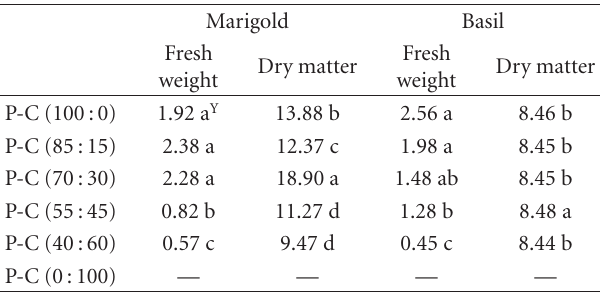
Table 2: Influence of substrate medium (commercial peat :CP; municipal solid waste compost:MSWC) at di ff erent ratios on seedling fresh weight (g/plant) and dry matter content (%) on marigold and basil plant grown in greenhouse nursery.